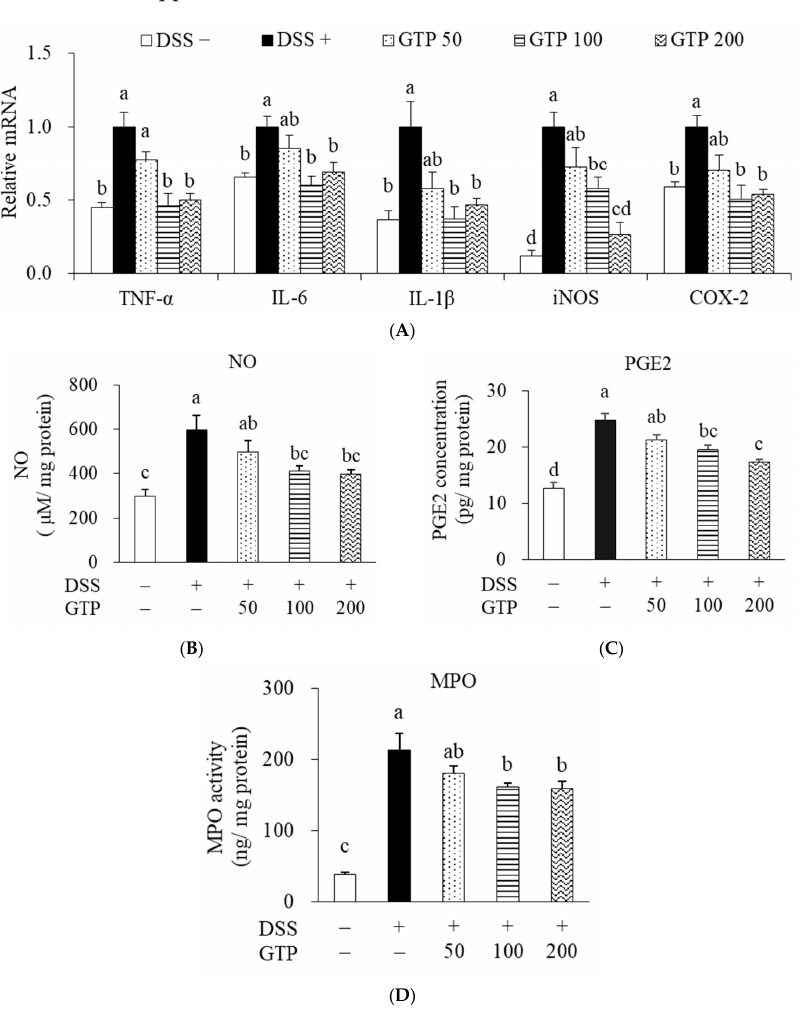
Figure 6. Effects of GTP on colonic inflammation. ( A ) The mRNA levels of TNF- α , IL-6, IL-1 β , iNOS, and COX-2. The concentrations of NO ( B ) and PGE2 ( C ). ( D ) MPO activity. Values are